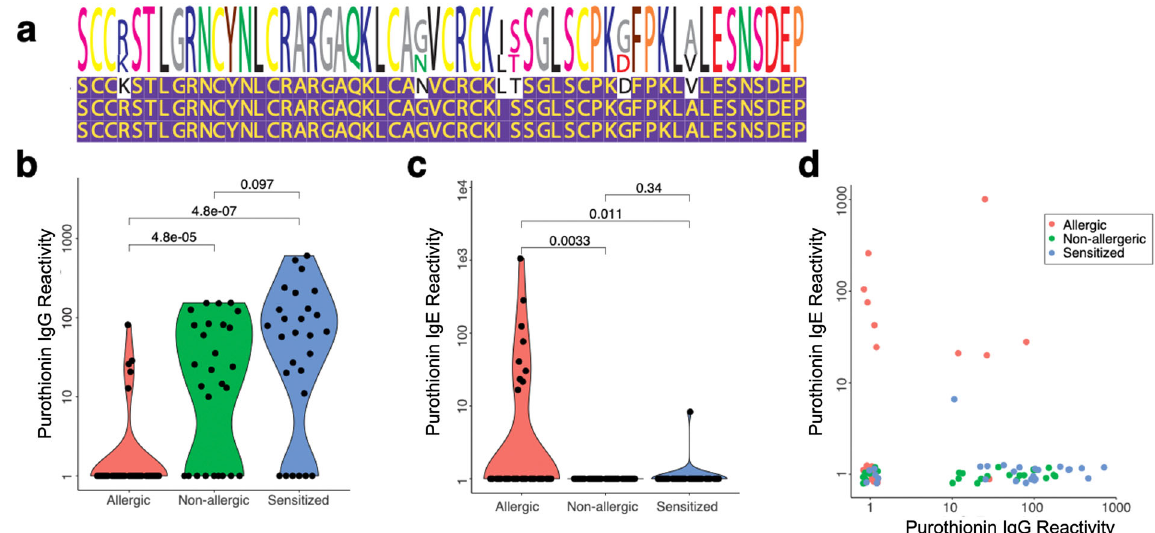
Fig. 4 Identi fi cation of a discriminatory IgG-reactive wheat epitope. a Multiple sequence alignment of three alpha purothionin peptides, which are b preferentially IgG reactive in the wheat non-allergic and sensitized populations, versus wheat allergic individuals. c IgE reactivities to the alpha purothionin epitope among the same three patient populations. d Comparison of the IgE versus the IgG reactivities to the alpha purothionin epitope. For b – d — wheat allergic ( n = 32), wheat non-allergic ( n = 27), and wheat sensitized ( n = 27). Source data are provided as a Source Data fi